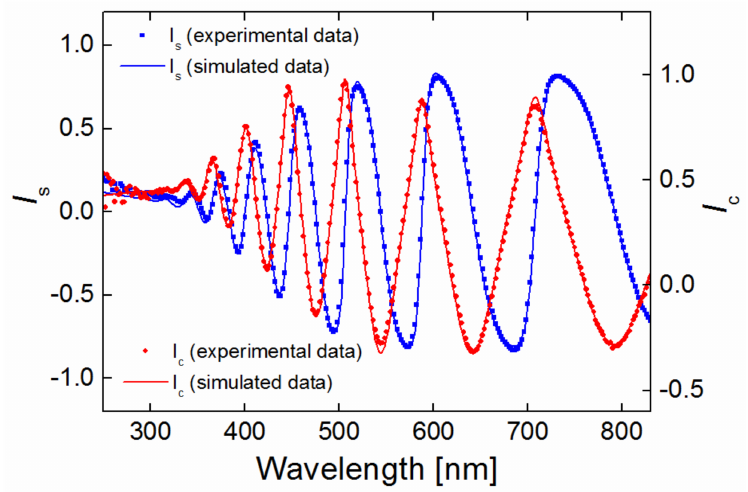
Figure 1. Experimental and simulated ellipsometric